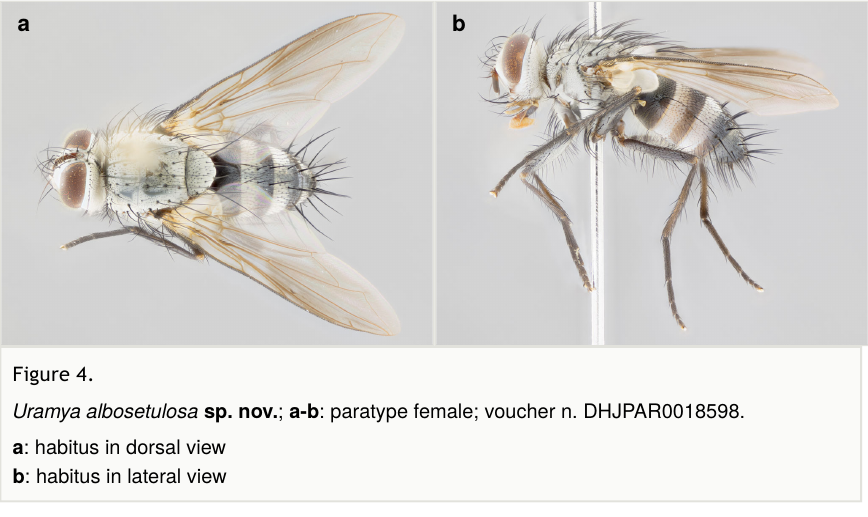
Uramya albosetulosa sp. nov. ; a-b : paratype female; voucher n.